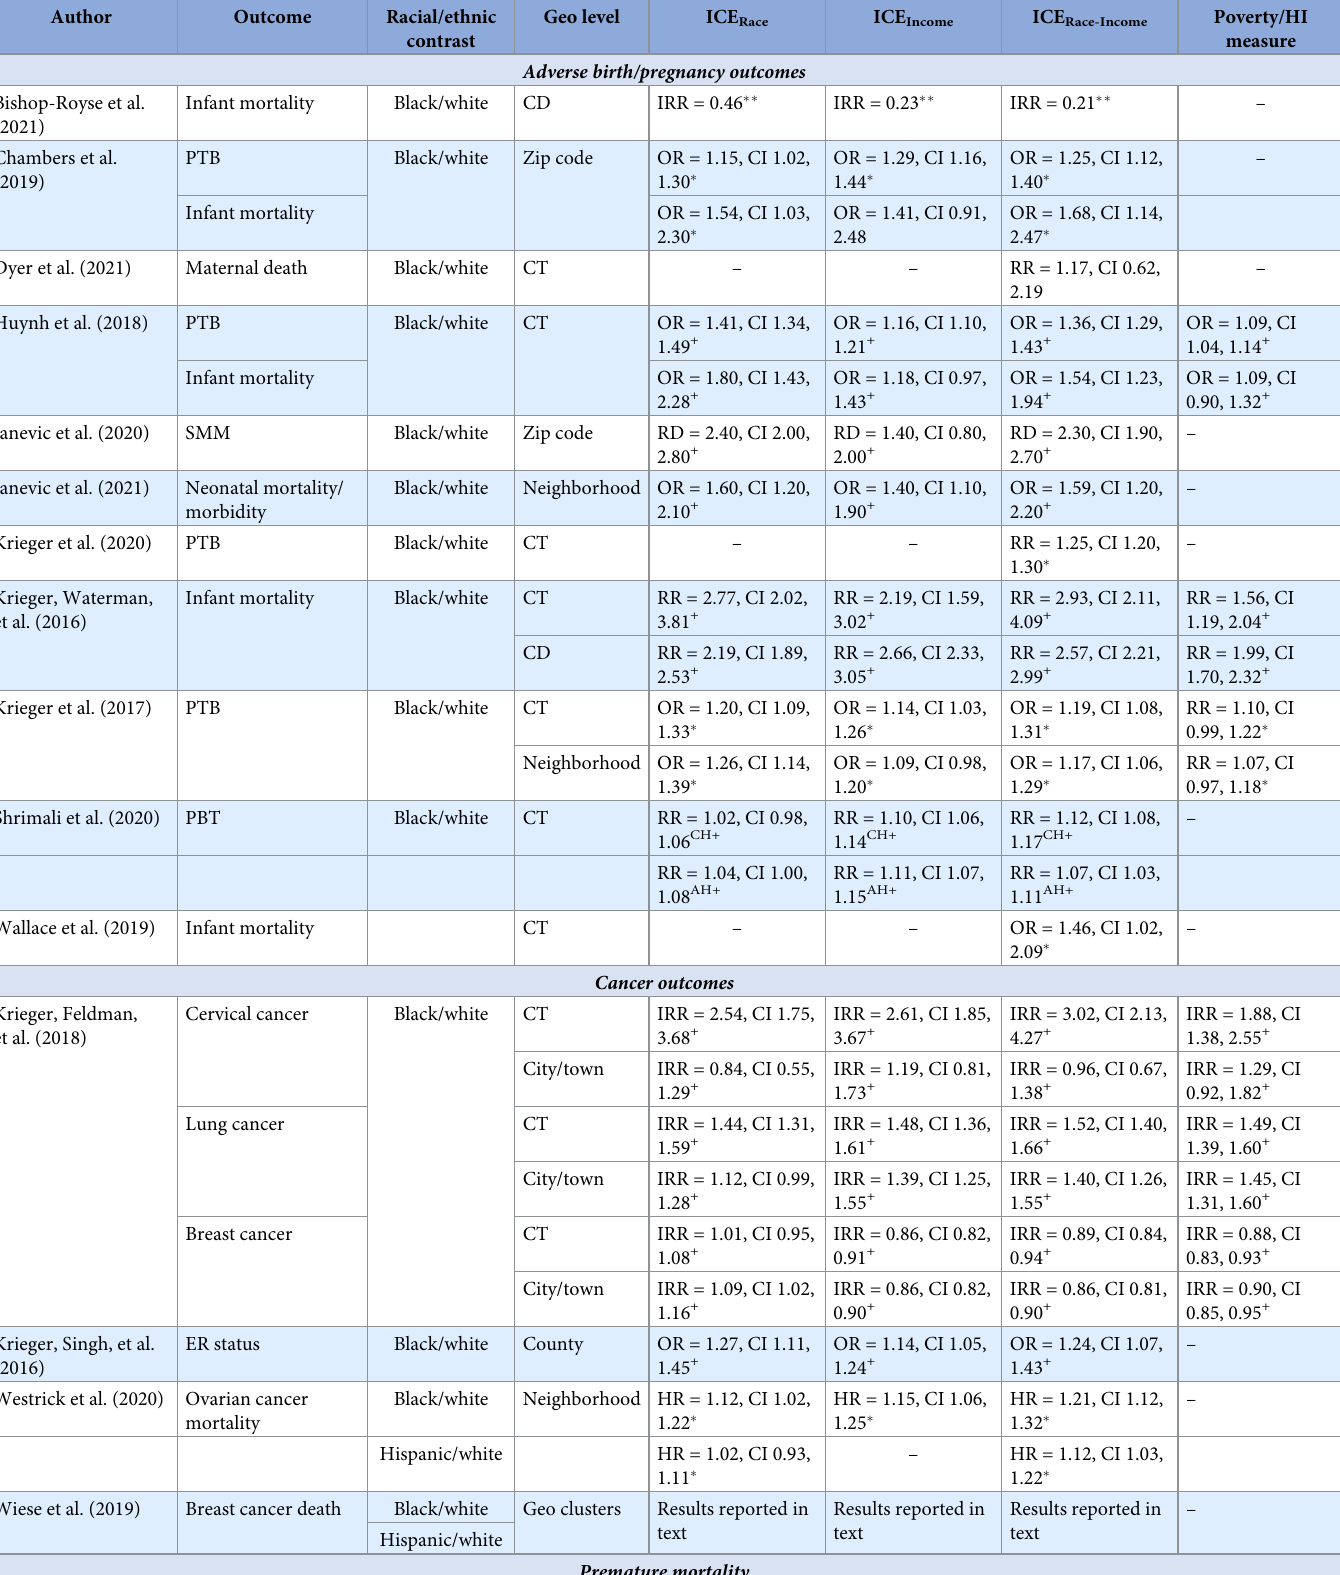
Table 2. ICE and poverty measure